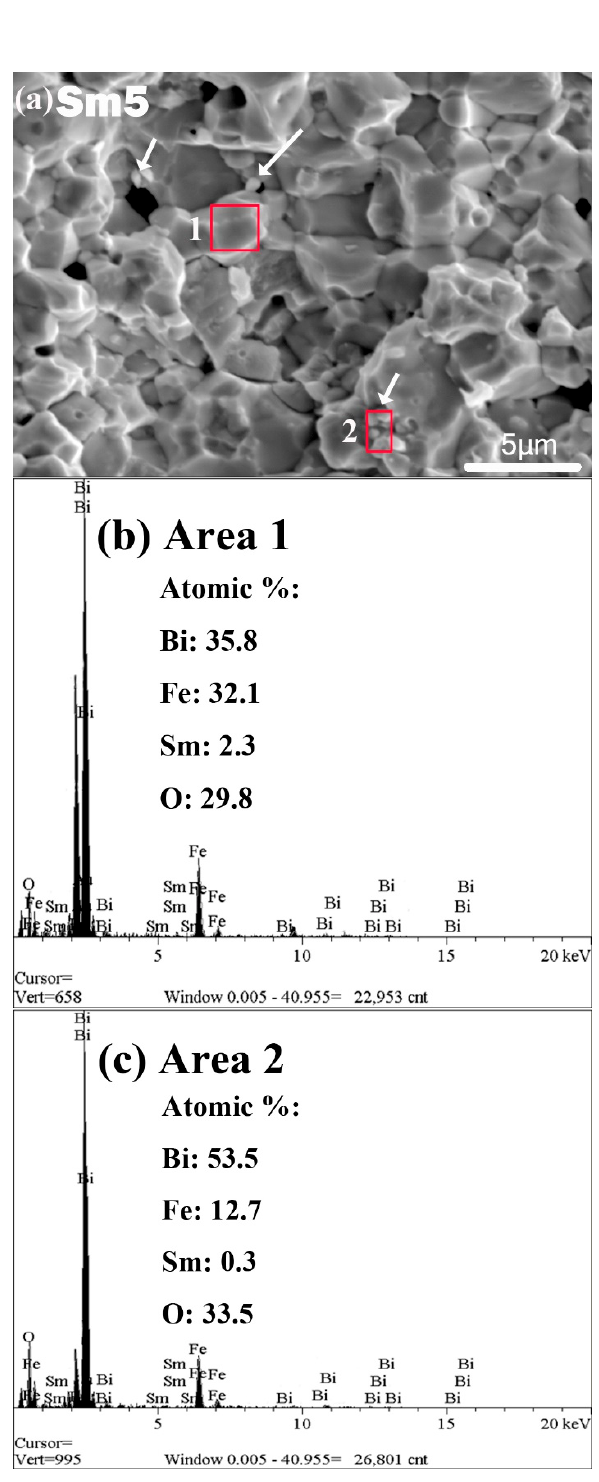
Figure 4. ( a ) SEM cross-section view of Sm5 sample, ( b , c ) are the EDX spectra obtained from the area 1 and area 2 as indicated in ( a ). The arrows in ( a ) indicates the Bi-rich secondary